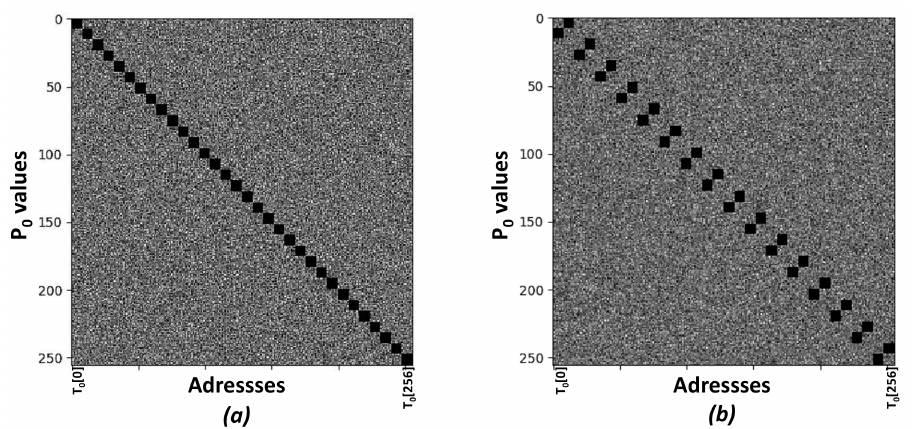
Figure 10. Cache access pattern to T 0 table using a Flush+Reload attack from the programmable logic part, ( a ) frequency = 250 MHz, ( b ) frequency = 100